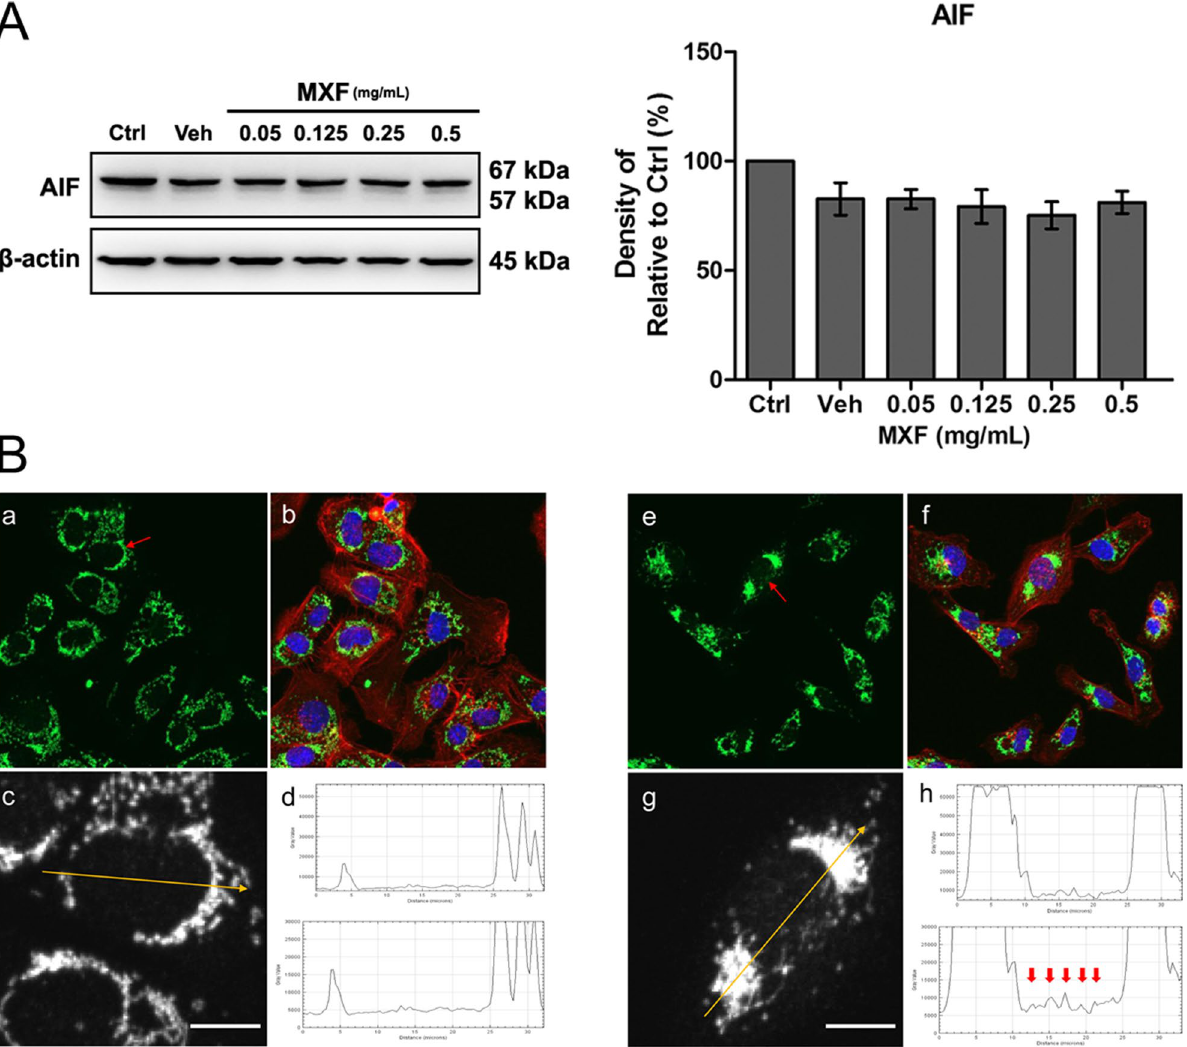
Figure 8. Apoptosis inducing factor (AIF) expression after MXF exposure in HCECs. ( A ) Total cellular expression level of AIF remained stable after MXF exposure. Note that only the bands at the adequate molecular weights were shown here. Full length gel and blots are included in the supplementary information. ( B ) Nuclear expression of AIF increased with MXF exposure. Panels a to d: control. Panels e to h: MXF 0.25 mg/ml exposure for 48 h; green: AIF; red: F-actin; blue: nucleus. Panels c and g are magnified gray scale images of cells (red arrow) in panels a and e. Panels d and h show the densitometry measured along the yellow arrow line in panels c and g. Red arrows in panel h indicate increased nuclear AIF signals. Full length electrophoresis gel image is available in supplementary files. Data shown are the representatives of three independent experiments. Ctrl: no treated normal control. Veh: 0.5% DMSO. Scale bar = 10